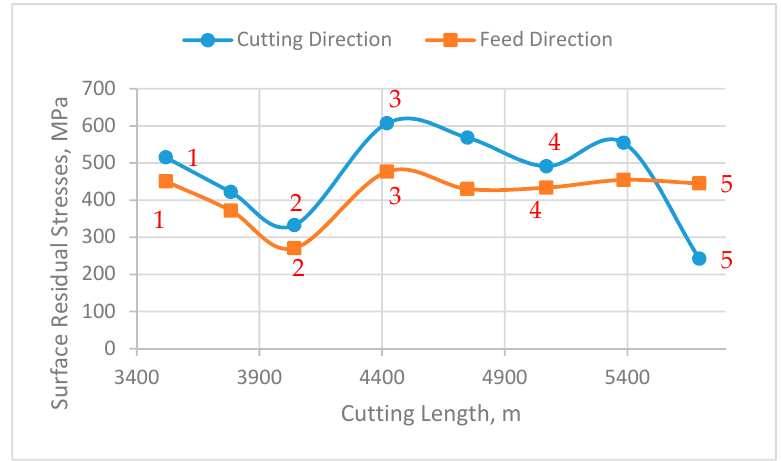
Figure 8. Relation between surface residual stresses and cutting length during steady state zone in cutting and feed directions.